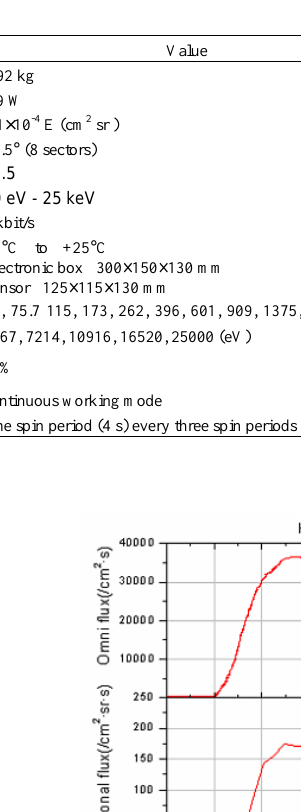
Table 5. Instrument data summary of LEID.